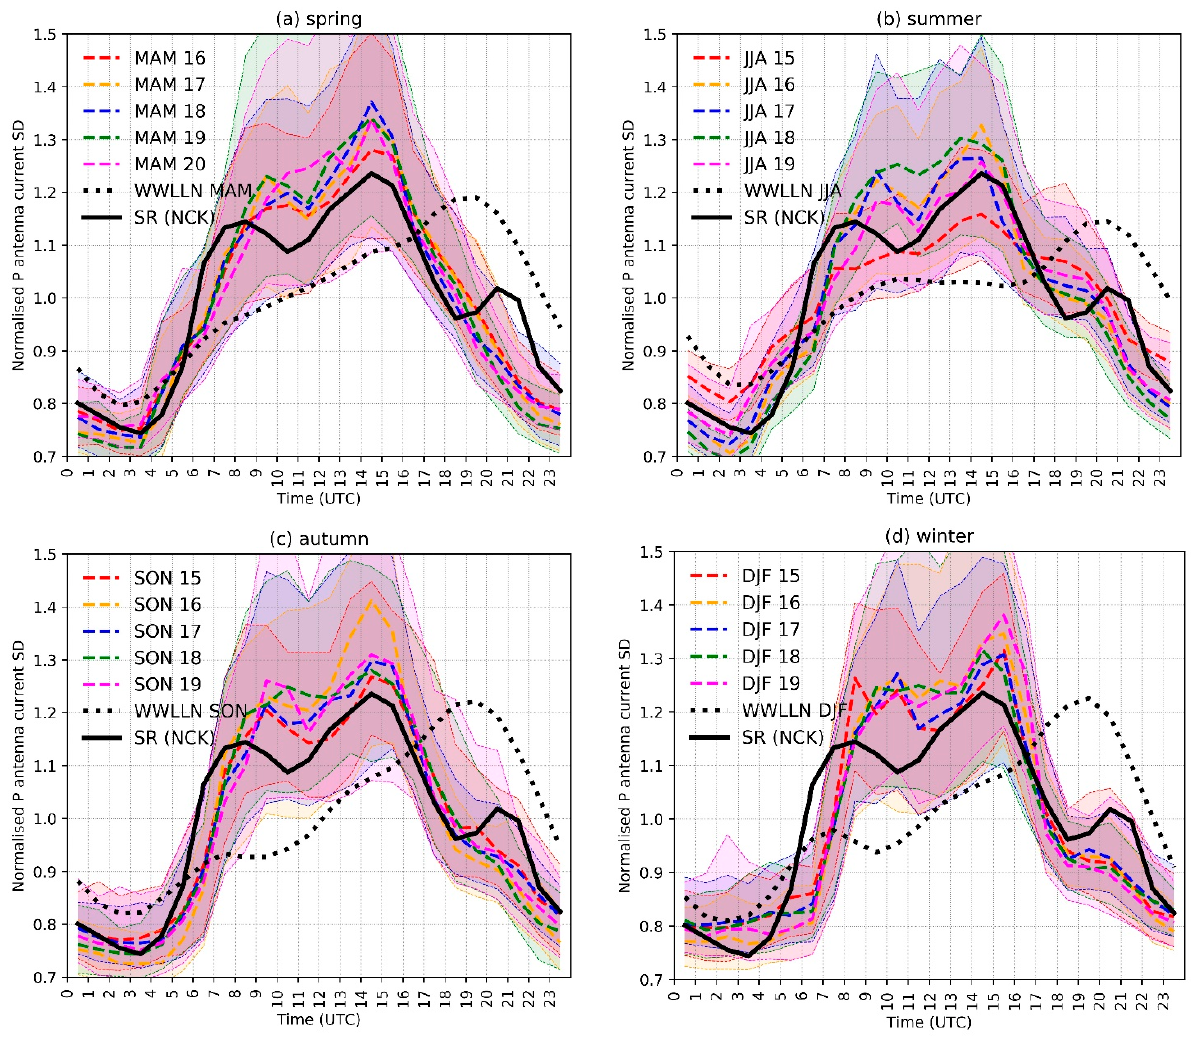
Figure 7. Seasonal diurnal variation (all days) of the standard deviation of current induced on the BTD-300 primary antenna in the 10-45 Hz frequency range (1 June 2015-31 May 2020). The normalised 1-h resolution median lines (dashed) are superimposed to the interquartile range (shaded area). The observed trend is compared with the seasonal diurnal variation of global thunderstorms derived from WWLLN data (2012-2013) [32] (dotted) and the cumulative intensity of the first 3 SR modes measured at NCK observatory (1994-1998) [14], both normalised by the mean.